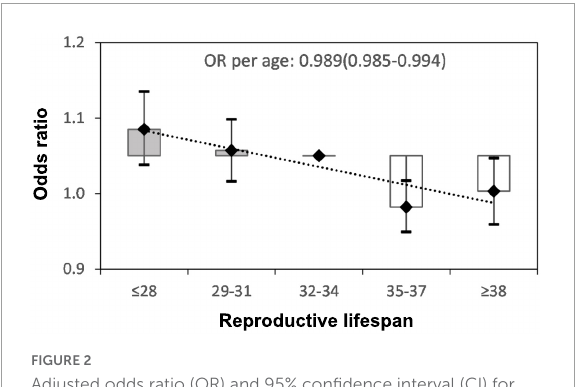
FIGURE2 Adjusted odds ratio (OR) and 95% confidence interval (CI) for hypertension by the years of reproductive lifespan. Adjusted for age at recruitment, body mass index, waist circumference, region, ethnicity, education level, smoking, alcohol drinking, family history of hypertension, stroke, myocardial infarction, pregnant, contraceptive use status, and breastfeeding